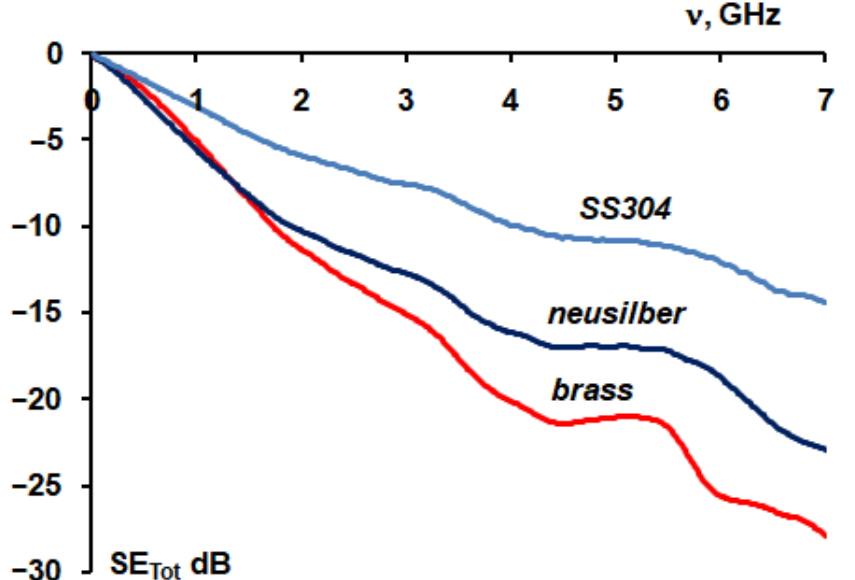
Figure 6. Frequency dependence of the calculated electromagnetic shielding for composites based on fabricated metallized glass fiber with 5 wt.% based on a material layer thickness of 250 mm.